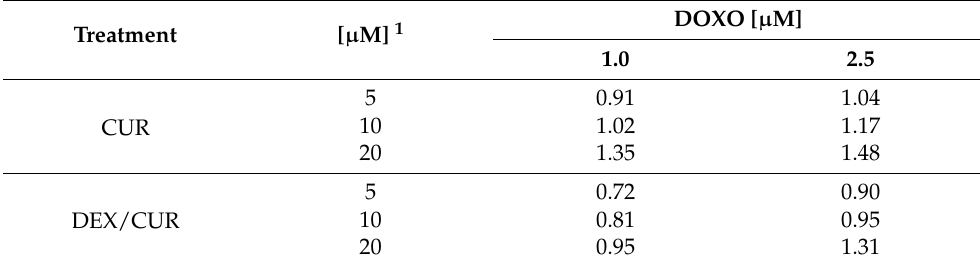
Table 2. Combination index for CUR/DOXO and DOXO@DEX/CUR combination treatments.